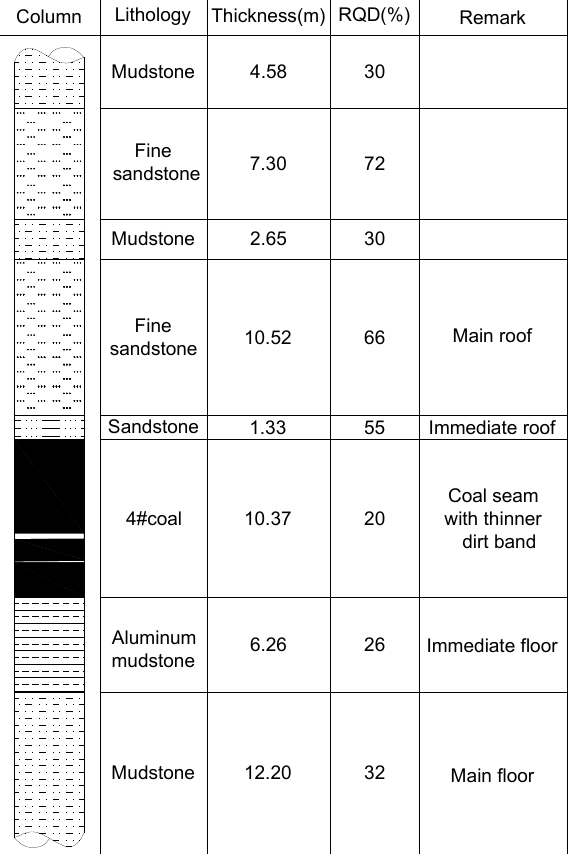
Figure 2. The stratigraphy of AR 4106.